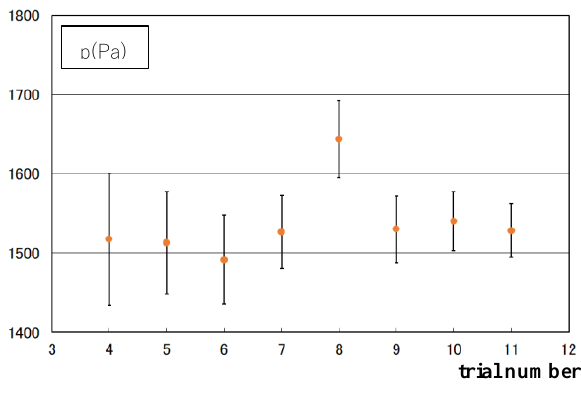
Fig. 7. Time average of pressure values (40mm).